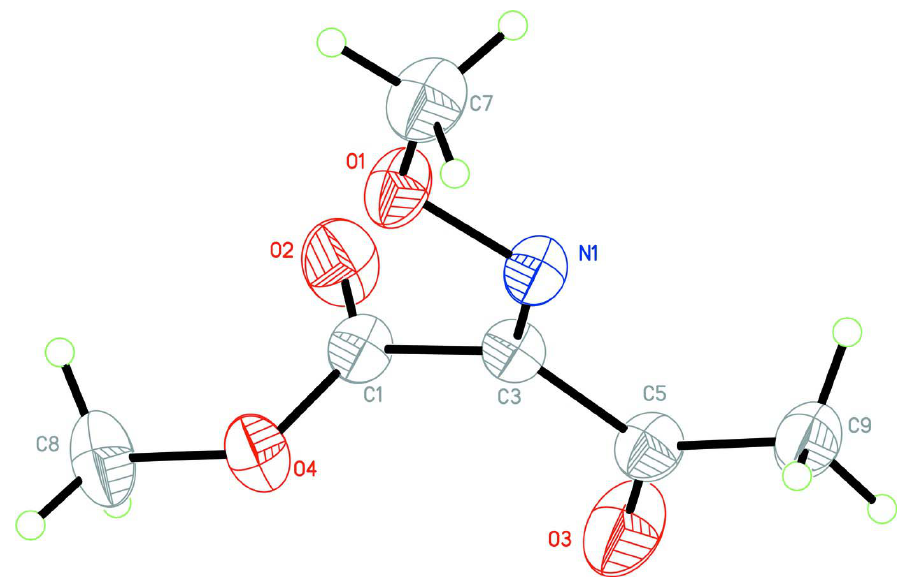
Figure 1 The molecular structure of (I) with displacement ellipsoids shown at the 30% probability level (arbitrary spheres for the H